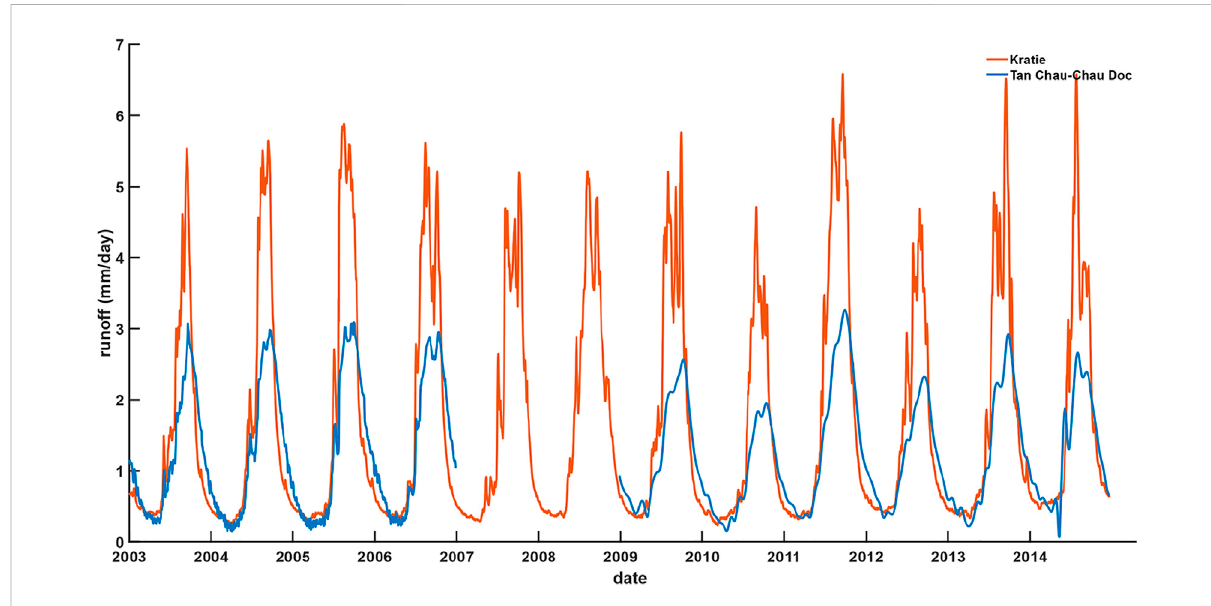
FIGURE 2 Runoff time series of the TC-CD and Kratie